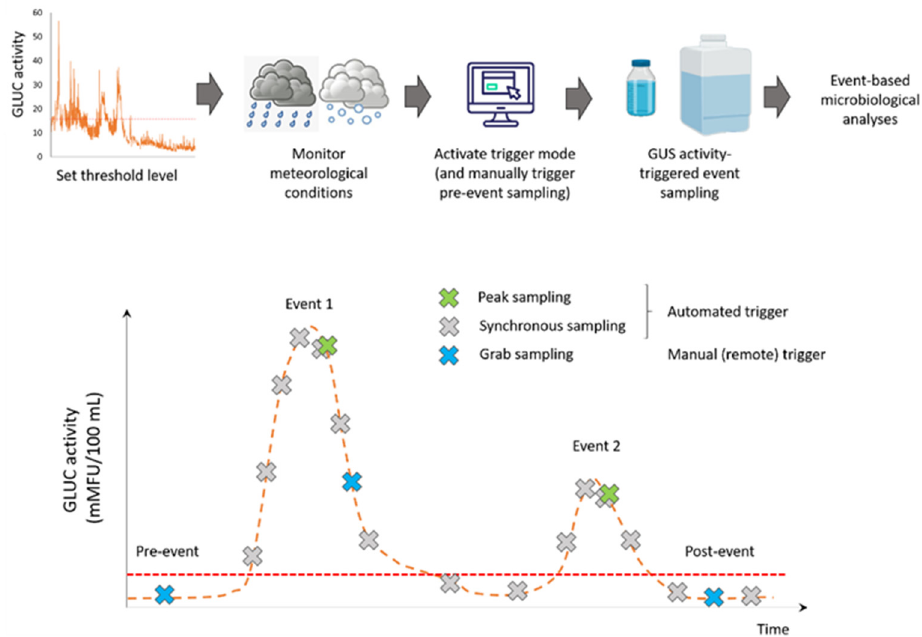
Figure 3. Proposed targeted event-based sampling methodology for microbiological water quality and risk assessment using autonomous near real-time monitoring of GLUC activity in surface wa- ters.